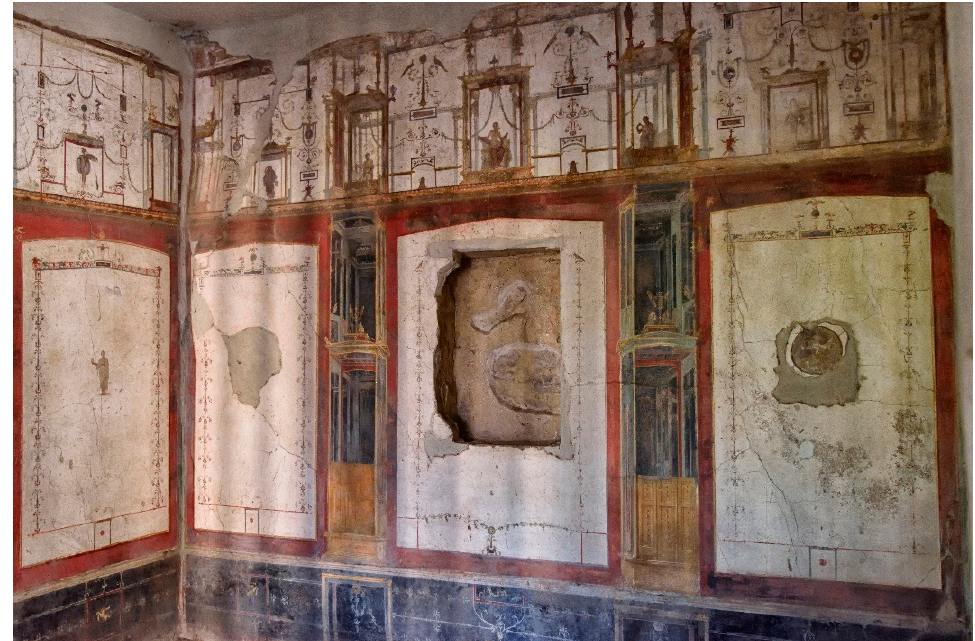
Figure 18. Room f of the House of Loreius Tiburtinus (= House of Octavius Quartio), decorated in the fourth style; © Ian Lycett-King. Creative Commons Attribution-NonCommercial License v.4 International. Courtesy Jackie and Bob Dunn www.pompeiiinpictures.com.